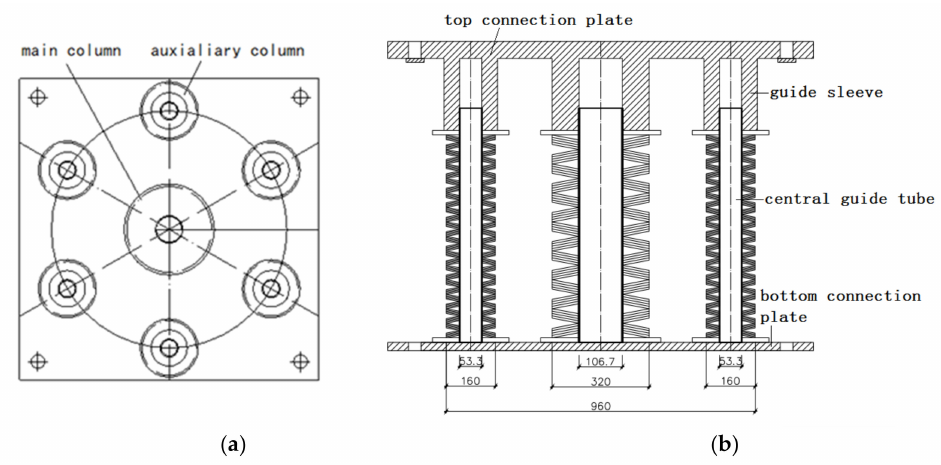
Figure 1. Typical plan and section view of the combined disk spring bearing (CDSB). ( a ) Plan view; ( b ) Section view.